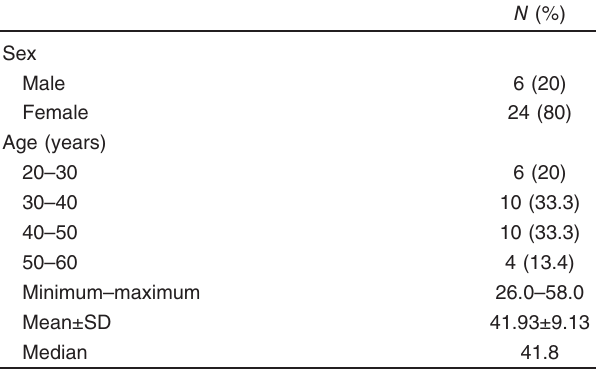
Table 1 Sex and age distribution in the studied group ( n = 30)